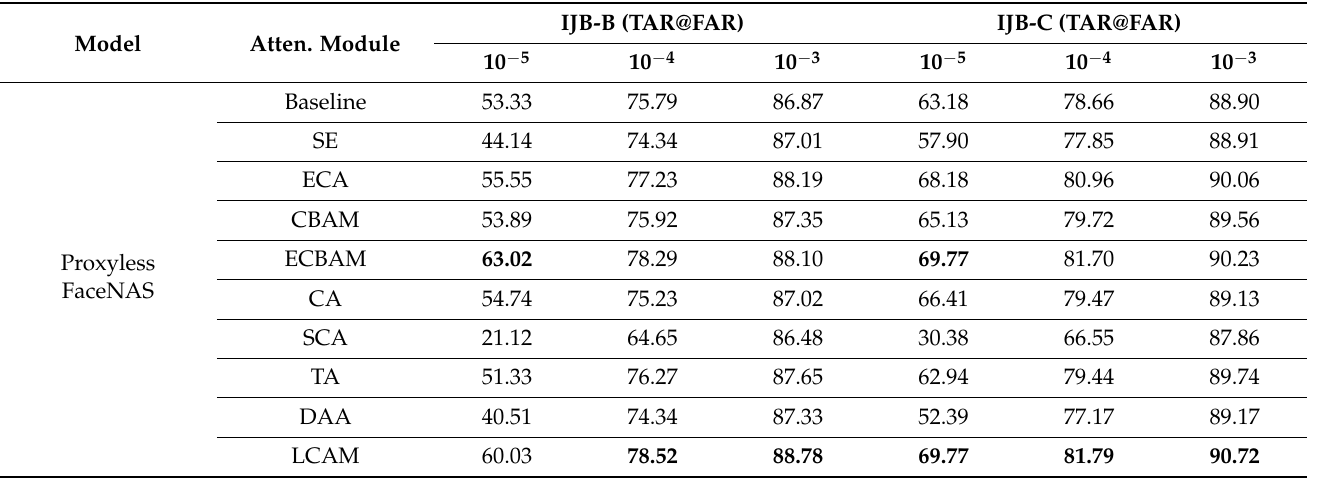
Table 12. Verification accuracy of ProxylessFaceNAS for IJB-B and IJB-C datasets. (Bold values are the highest obtained values by the